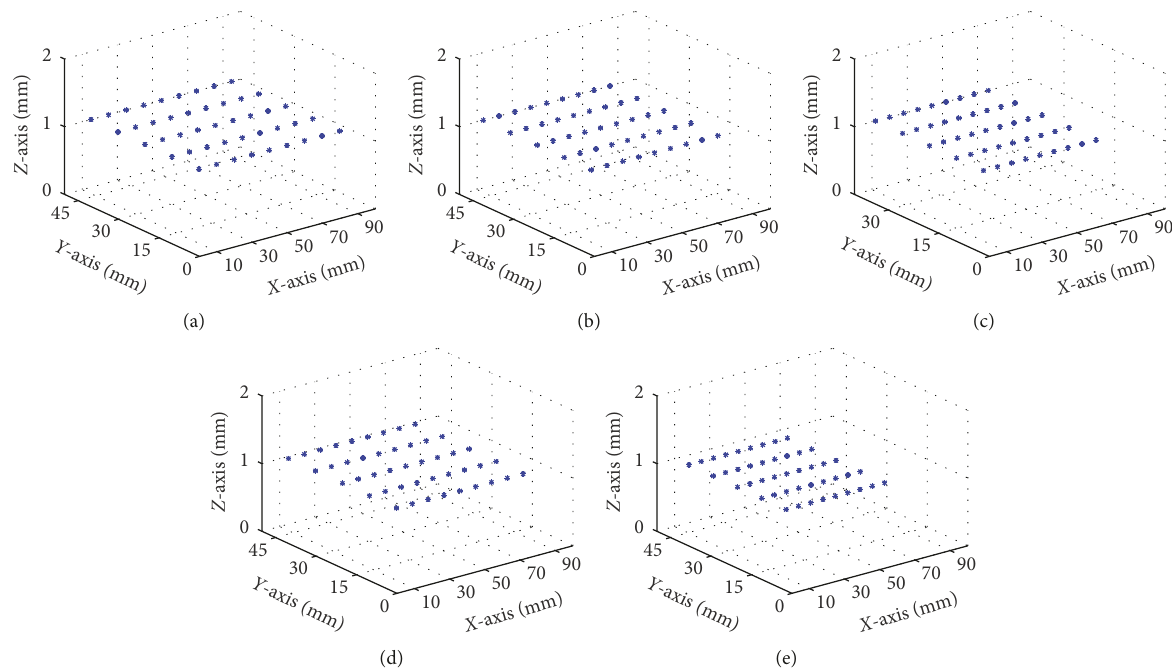
Figure 7: Reconstruction results with the intrinsic parameters in Table 1 for (a) our method ∗ , (b) our method+, (c) our method, (d) Wu’s method, (e) Meng’s